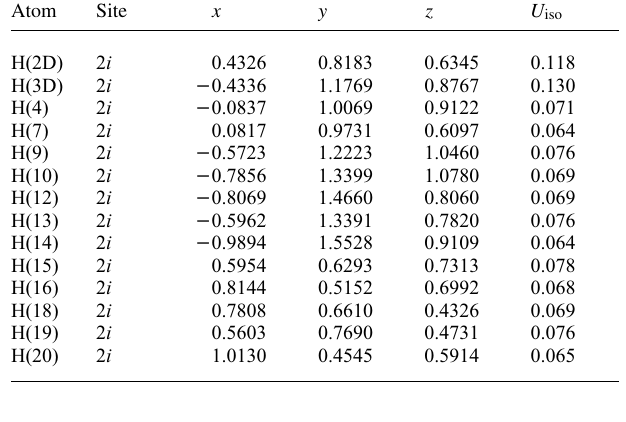
Table 3. Atomic coordinates and displacement parameters (in Å 2 ) .